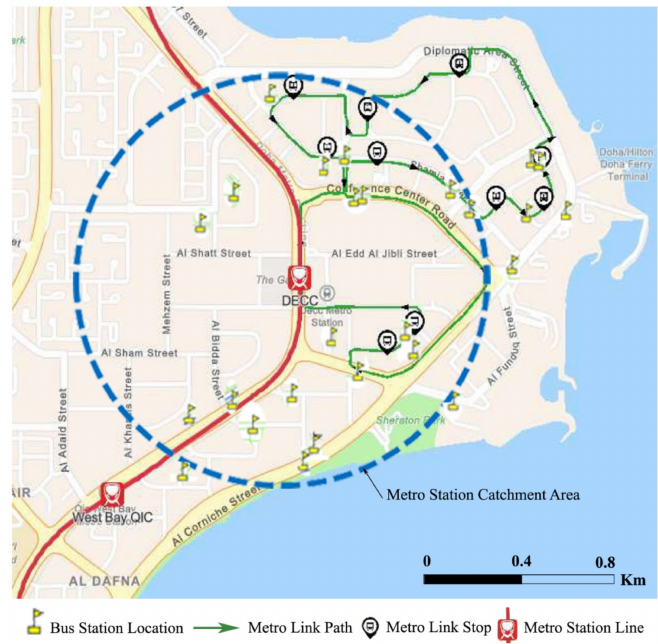
Figure 18. Bus Network and Metrolink